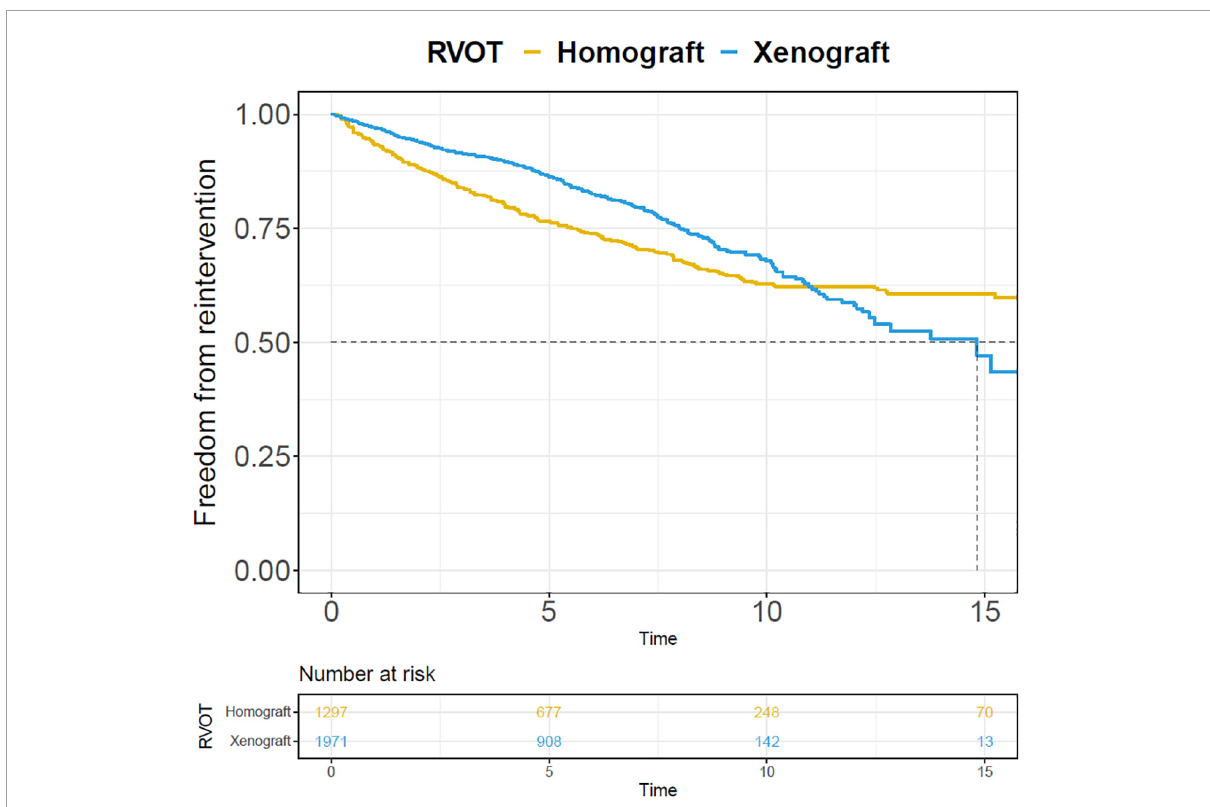
FIGURE6 Pooled Kaplan-Meier curves of freedom from reintervention of two subgroups: right-sided conduit RVOT with xenograft and homograft. The blue line stands for xenograft and the yellow line stands for